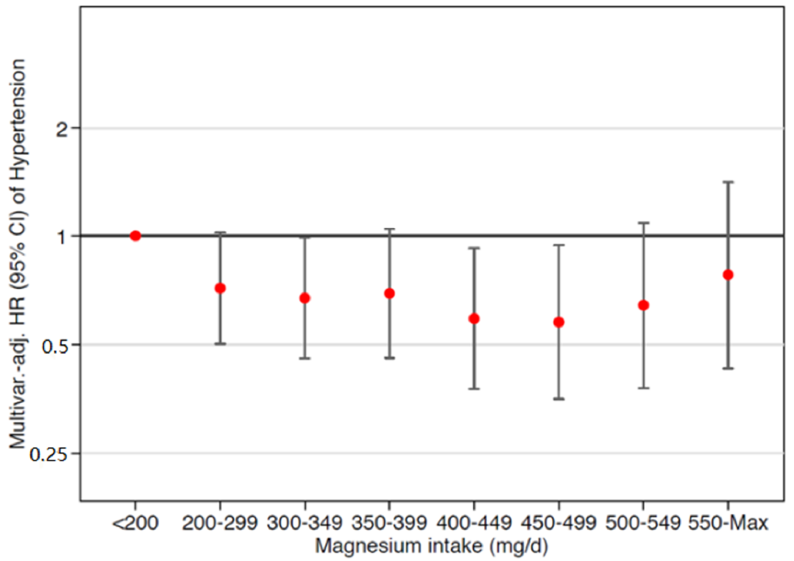
Figure 1. Multivariable-adjusted hazard ratios for incident hypertension by categories of magnesium intake (from <200 mg/d to >550 mg/d). The model was adjusted for age, sex, BMI, total energy intake, following special diets at baseline, physical activity, alcohol consumption, smoking, marital status, body weight changes, years of university education, borderline hypertension at baseline, family history of hypertension, year of entrance to the cohort, sodium intake, potassium intake, calcium intake, hours per day spent watching television, analgesic consumption, and sugar-sweetened beverage consumption.